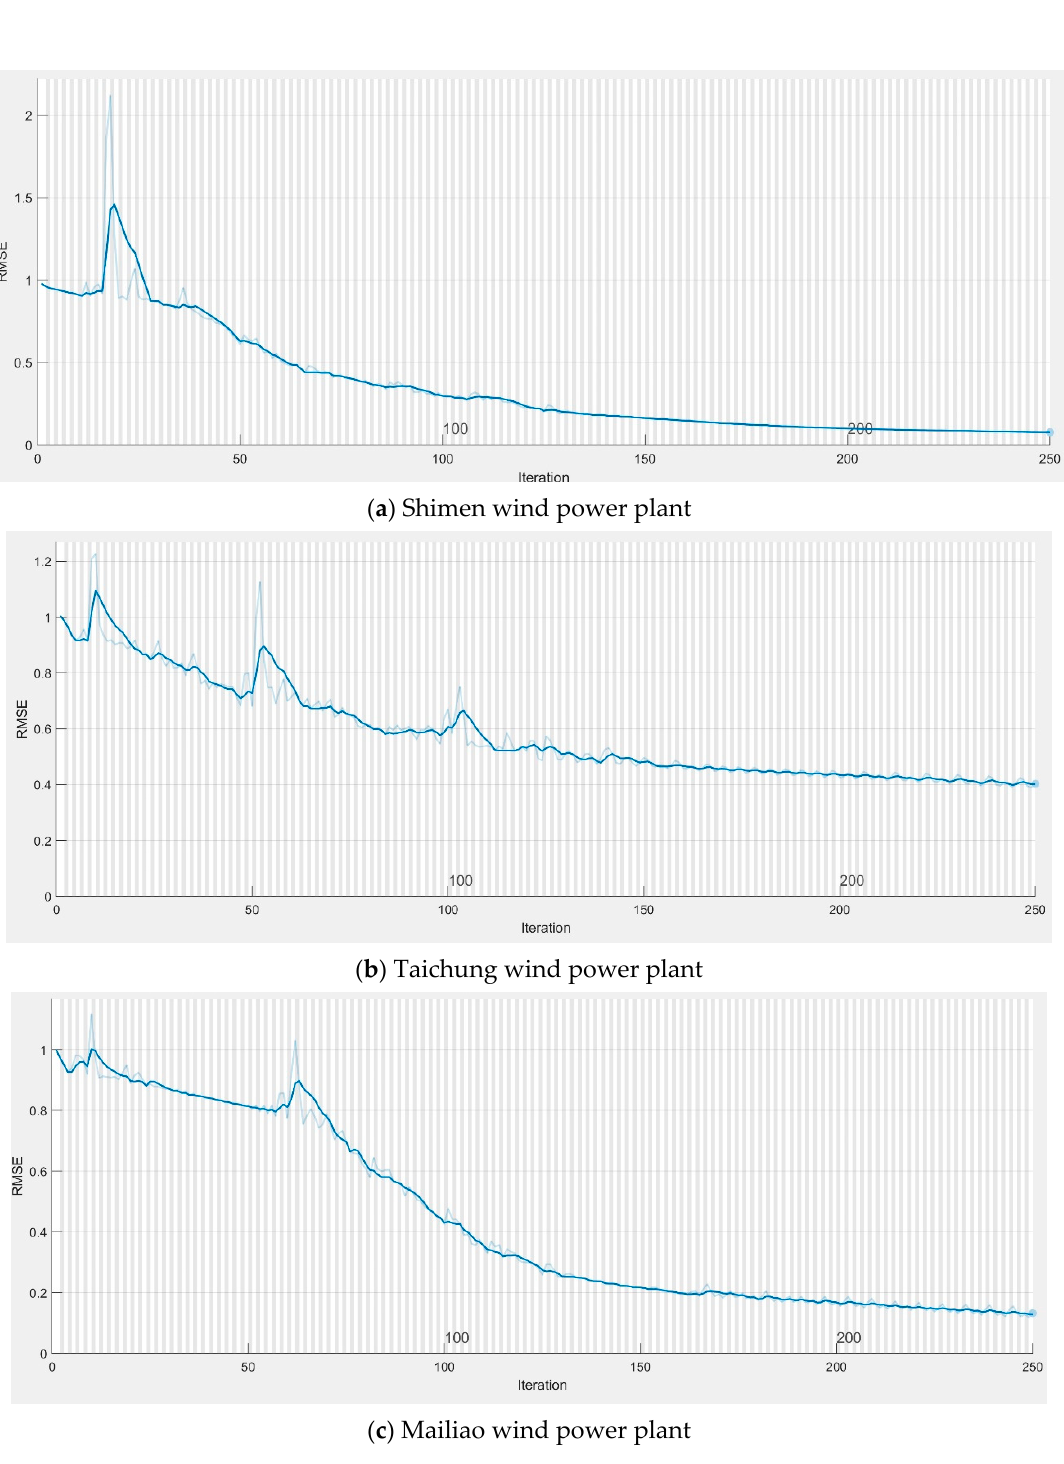
Figure 4. Illustration of the training error of the FSLSTM for the three wind power stations. In this study, the FSLSTM, LSTM [8], ARIMA(1, 0, 0) [25], generalized regression neural network (GRNN) [26], back propagation neural network (BPNN) [27], least square support vector regression (LSSVR) [28], and seasonal autoregressive integrated moving average (SARIMA (1, 0, 0) (1, 0, 0) 12 ) [25] models were used to forecast the monthly wind power output datasets in selected stations in Taiwan. The construction of LSTM is similar to that of the FSLSTM (see Section 2.1). The LSTM network also adopted the Adam optimization algorithm to search for optimal parameters. The ARIMA is similar